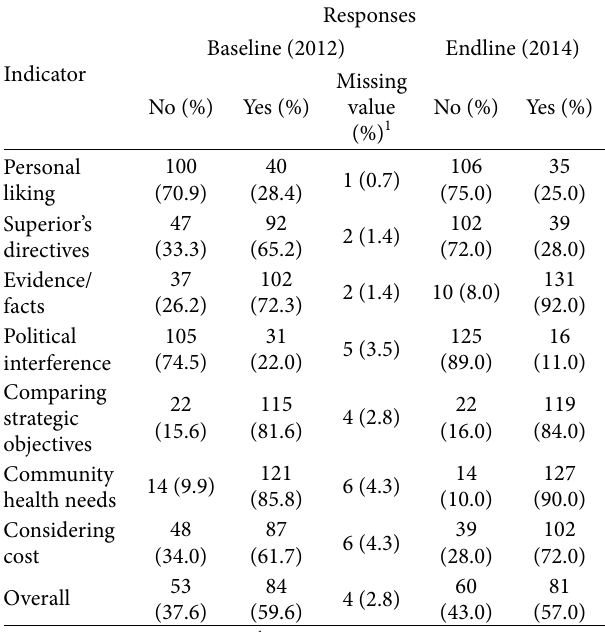
Table 1: Promotion of evidence-based